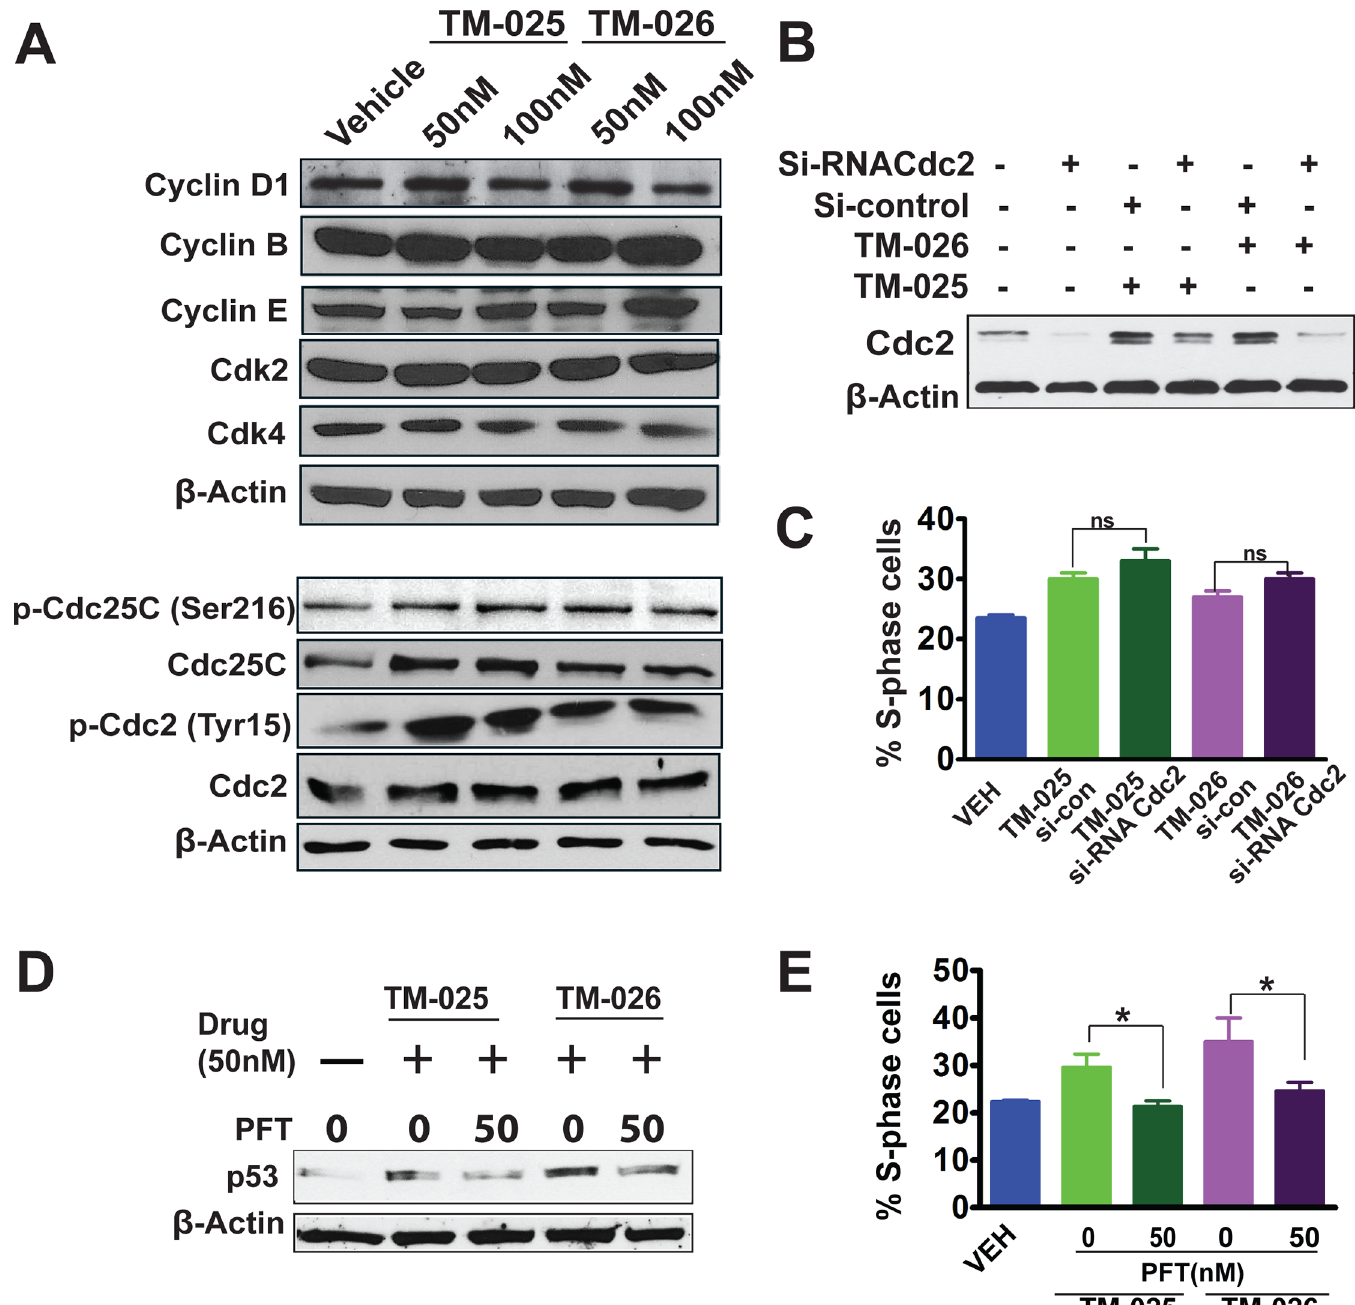
Fig 7. Altered expression of key cell cycle regulators, silencing of Cdc2 and inhibition of p53 in SCC25 cells by the PCT analogs. (A): Immunoblotting showed mild dose-dependent (50 and 100 nM) reduction in the expression of cyclin D1, moderate induction of cyclin E, and no or negligible effect on cyclin B. Both PCT analogs did not cause any change in the levels of Cdk2 and Cdk4, but induced the expression of Cdc2 (Cdk1) and Cdc25C. The analogs significantly augmented phosphorylation of Cdc2 at the Tyr15 residue, thus upregulating the level of phospho-Cdc2(Tyr15), which is an inactive form of Cdc2. Induction was also observed in the expression of phospho-Cdc25C(Ser216) in samples treated with TM-025/TM-026. Equal loading was confirmed by β -actin. Quantifications are shown in S4 Fig Part B. (B): siRNA mediated silencing of Cdc2. Cells were transfected with Si-Cdc2 and si-Con (control), and 24h later 50 nM of PCT analogs were added and incubated for 24h and harvested for protein extraction. Immunoblots showed knock down efficiency of the Cdc2 siRNA. Briefly, the gel showed untransfected cells, Cdc2 siRNA-transfected cells, Cdc2 siRNA or control siRNA-transfected cells treated with 50 nM PCT analogs. (C): Bar graph shows % S-phase cells after cell cycle analysis of propidium iodide (PI) stained cells. NS: not significant. (D): Pharmacological inhibition of p53 by PFT. Cells were treated with vehicle, PCT analogs, and PCT analogs with multiple doses of 50 nM PFT. Western blots showing inhibition of p53 by PFT at 72 h in TM-025 and TM-026 (50 nM) treated SCC25 cells. (E) Bar graph shows % S-phase cells after cell cycle analysis of PI-stained cells. Results showing significant changes are denoted by * (P < 0.05) and not significant denoted as ns. β -Actin was used as loading control for A, B and D.